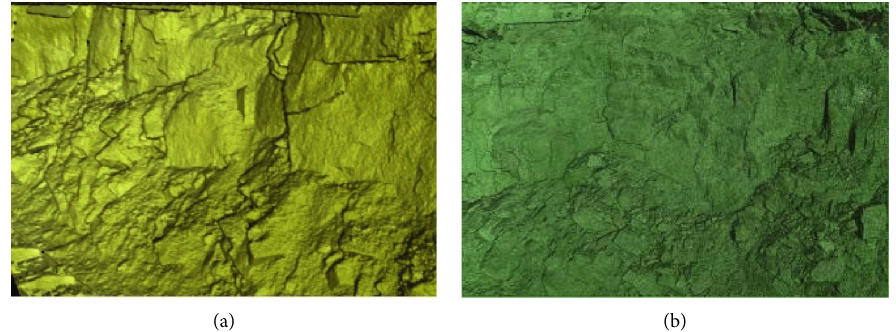
Figure 9: Comparison of failure modes of the 12401 coal wall. (a) Before increasing the strength of the shield. (b) After strengthening the strength of the